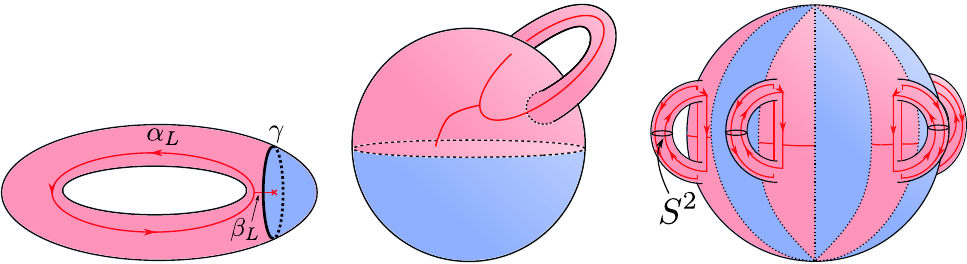
Figure 11 . The state on the torus and (middle) the same state redrawn suggestively. (Right) The three-manifold of the replica path